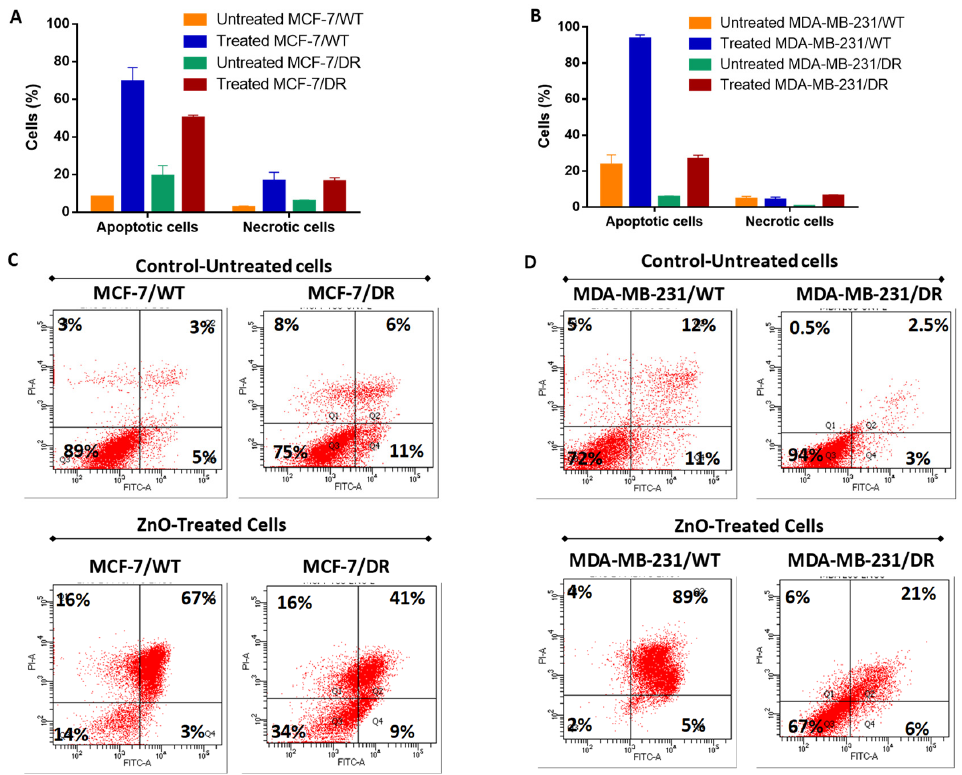
Figure 6. Flow cytometric analysis of the cell death modality. Breast cancer cell lines: MCF-7/WT MCF-7/DR, MDA-MB-231/WT, and MDA-MB-231/DR cells were treated 24 h with 10 µg/mL ZnO NPs and stained with FITC-conjugated annexin V and PI-stained, compared to the untreated control cells. ( A , B ). Average (%) of apoptotic and necrotic cells after treatment. ( C , D ) The quadrants in the dot plot indicate viable cells (lower left quadrant), early apoptotic cells (lower right quadrant), ne- crotic cells (upper left quadrant), and late apoptotic cells (upper right quadrant) ( n = 3).